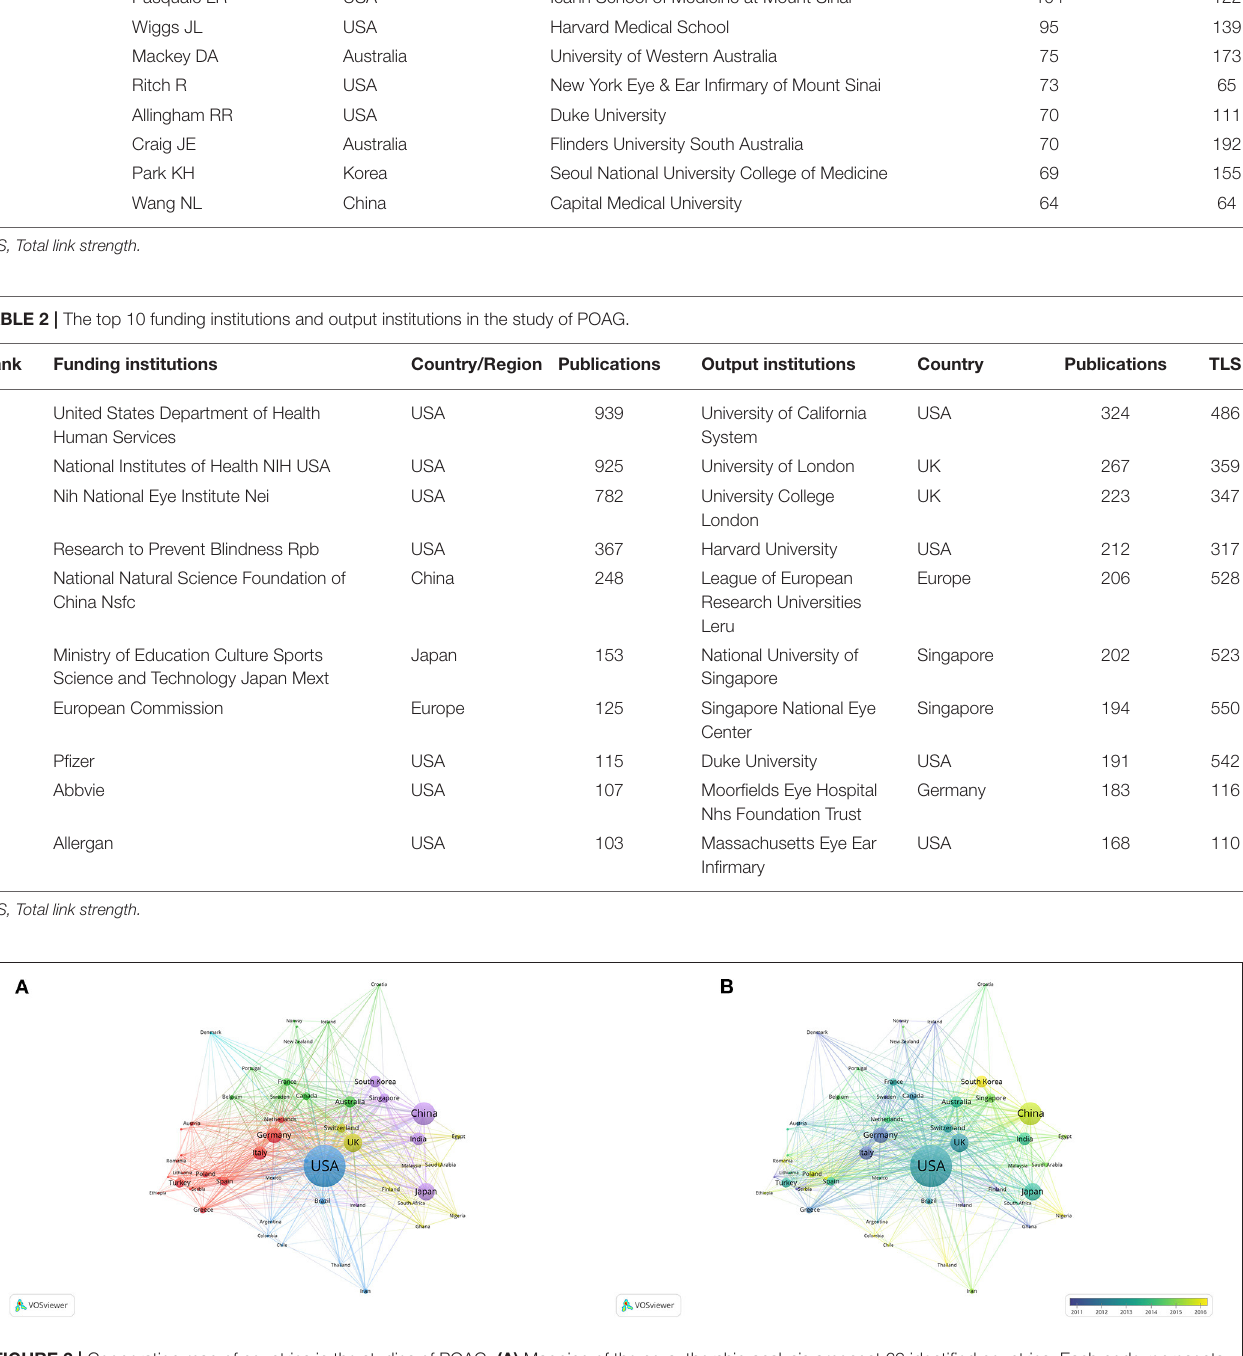
Frontiers in Medicine |